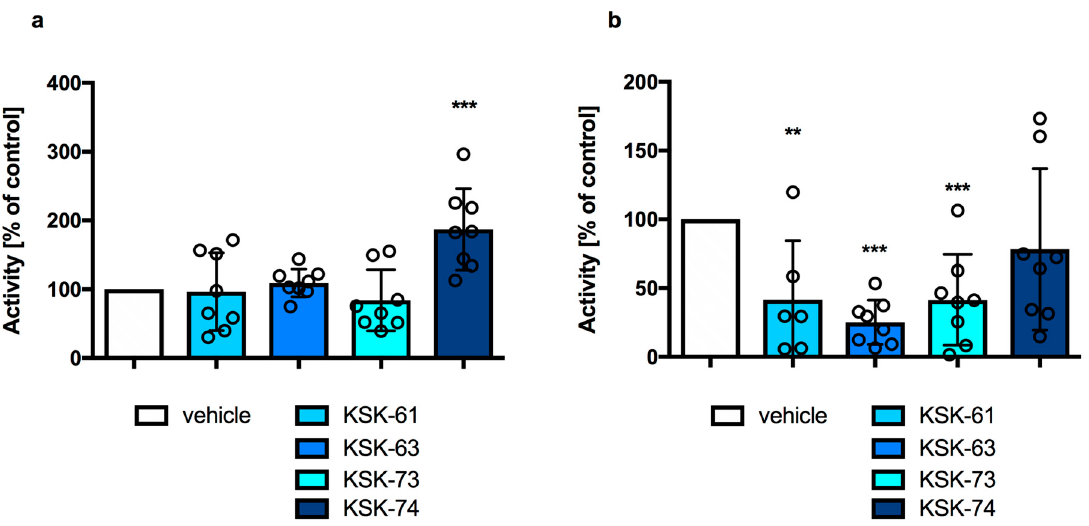
Figure 1. Locomotor activity in mice after a single administration of the tested compounds at a dose of 10 mg/kg b.w. ( a ) or at a dose of 30 mg/kg b.w. ( b ). Results are presented as mean ± SD, n = 6–8. Statistical analysis: Shapiro–Wilk normality test and unpaired t -test, ** p < 0.01; *** p < 0.001 vs. vehicle group.